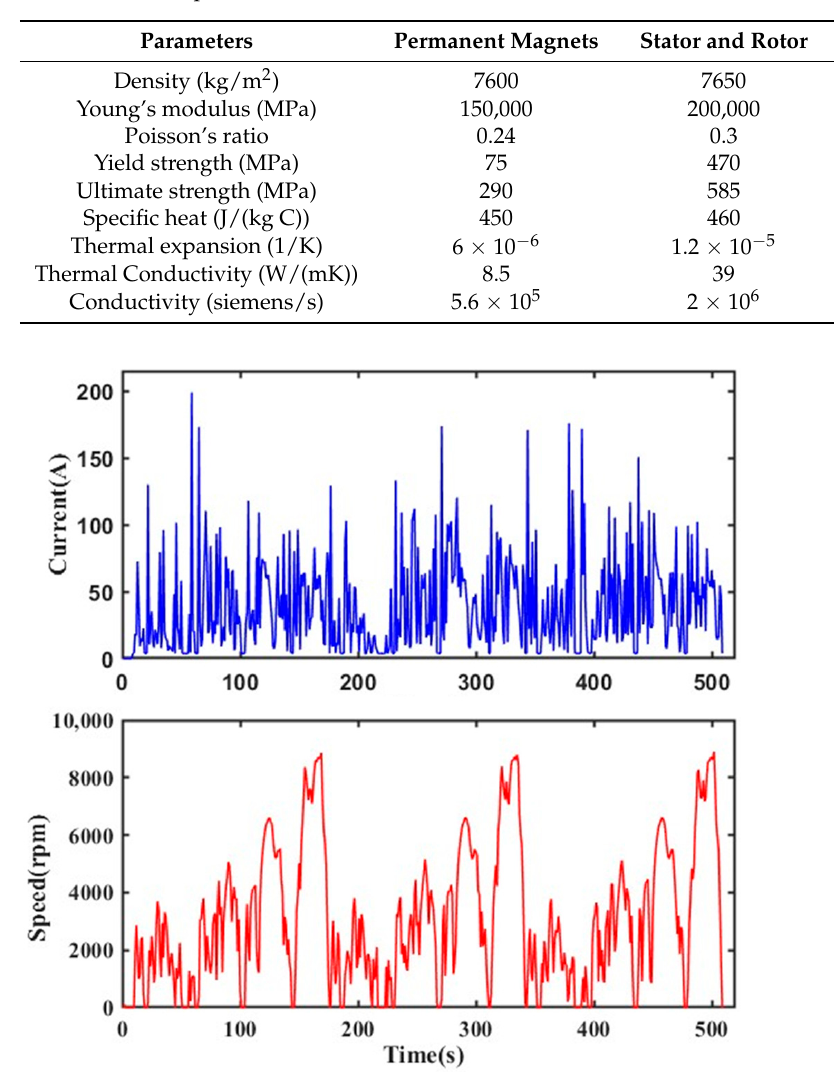
Table 2. Material parameters of PMSM.